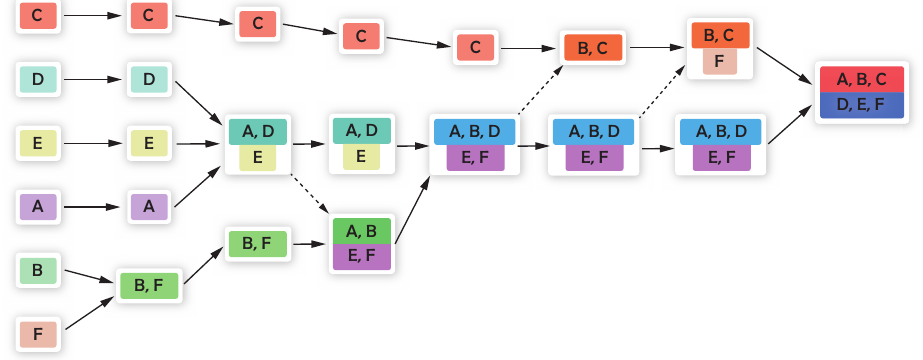
Figure 4. Quasi-dendrogram generated by